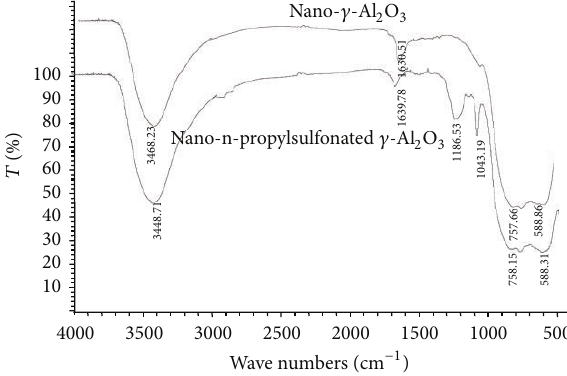
Figure 1: FTIR spectra of nano- 𝛾 -Al 2 O 3 (up) and sulfonic acid functionalized nano- 𝛾 -Al 2 O 3